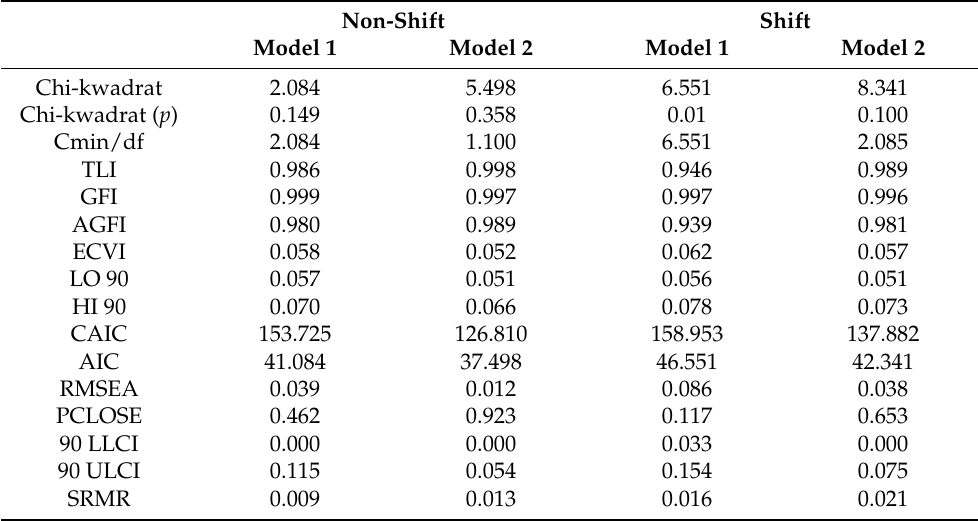
Table 3. List of model fitting values (1—sample model and 2—the best fitted model after paths have been